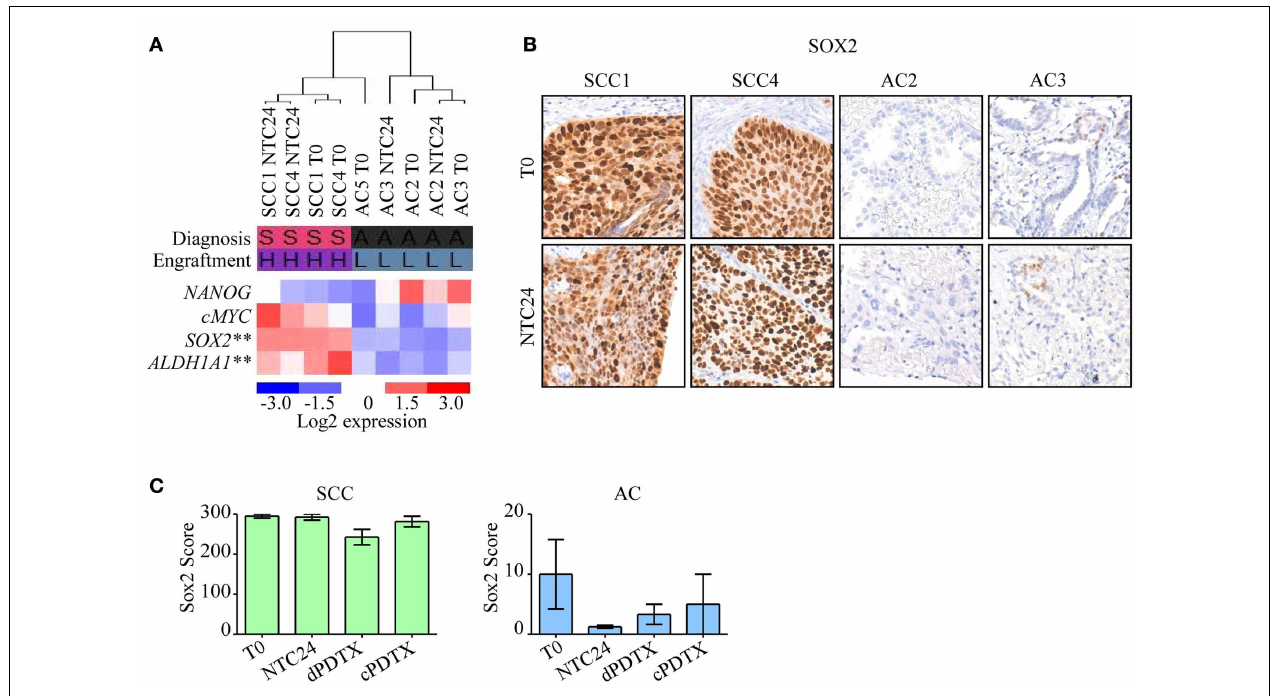
(** p < 0.001, by ANOVA). Diagnosis: S, SCC; A, AC. Engraftment: H, high; L, low. (B) Representative SCC and AC cases stained with an antibody directed against SOX2 at T 0 and after 24h of ex vivo cultures (NTC24). Original magnification 200 × . (C) SOX2 immunoreactivity is shown for SCC- and AC-PDTXs and their relative controls. For all experiments, bars represent mean ±